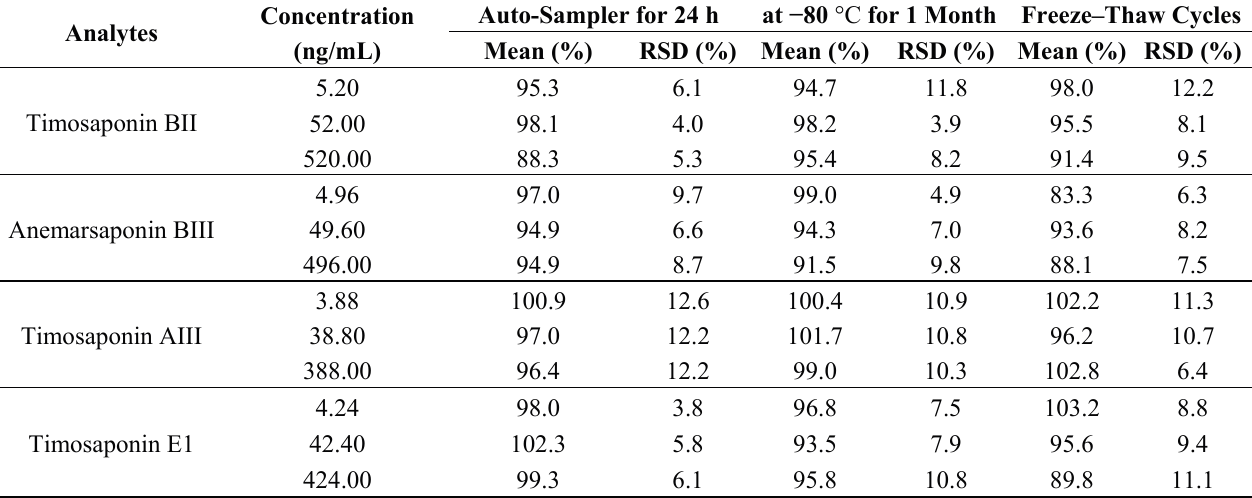
Table 4. Stability for four analytes in rat plasma ( n =